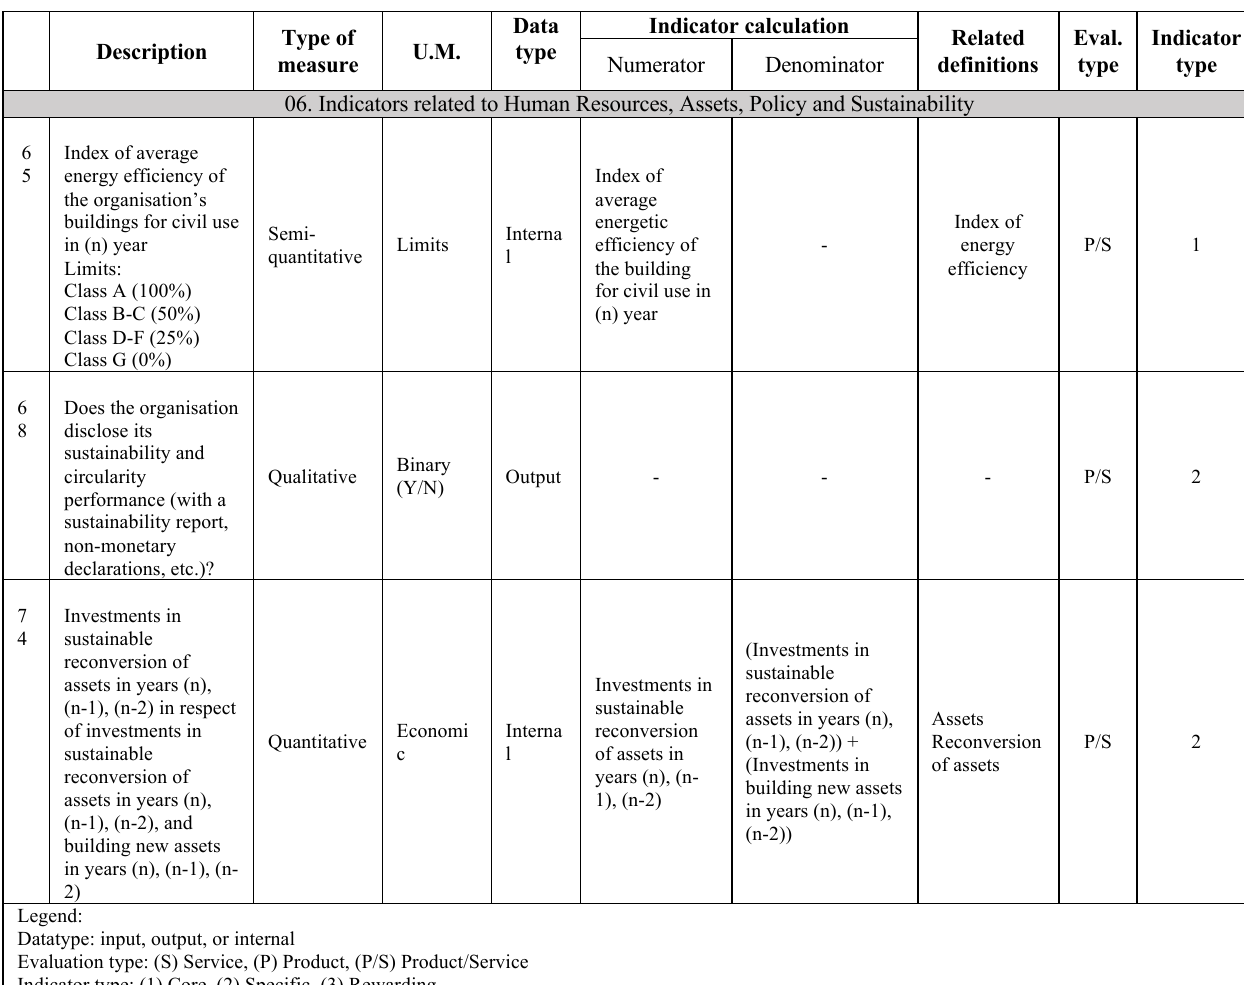
Indicator calculation